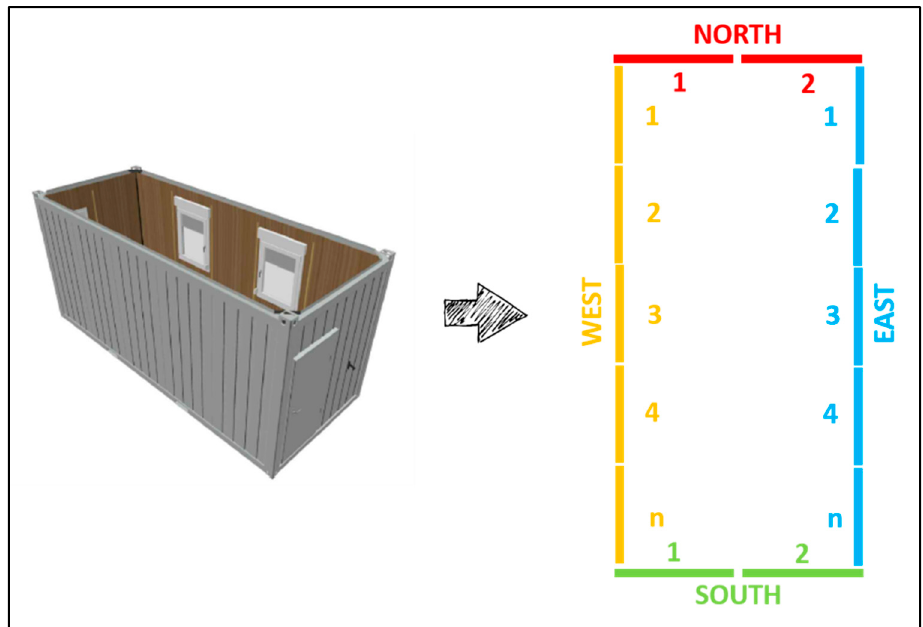
Figure 3. General container and panel layout.